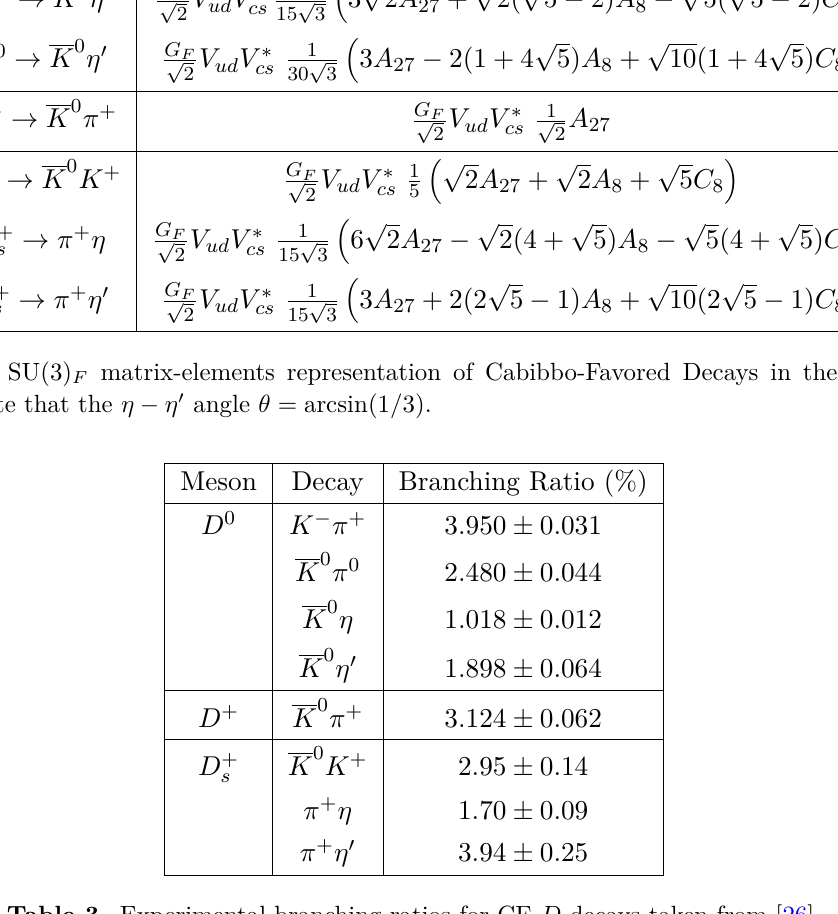
Table 3. Experimental branching ratios for CF D decays taken from